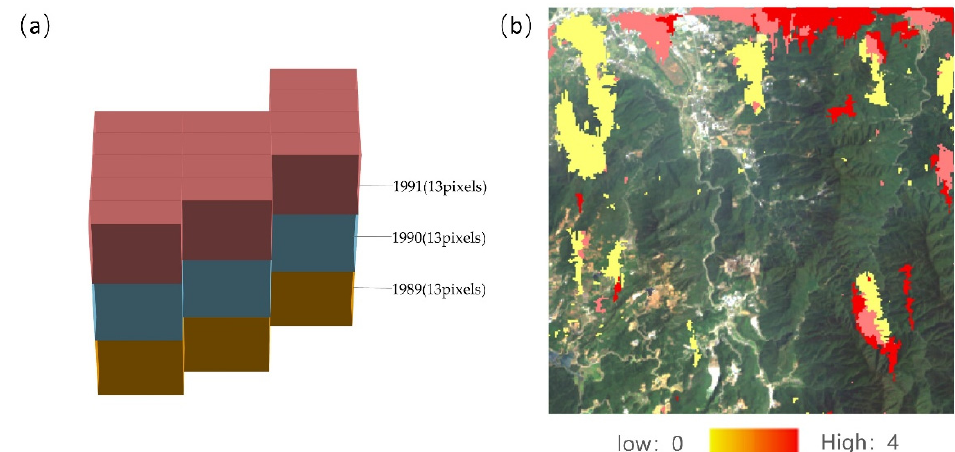
Figure 14. ( a ) Actual SS IST-cube diagram, containing three layers representing three years. The average number of pixels per year is 13, conforming to the criterion for the SS IST-cube class. ( b ) Spatial distribution map of occurrence number of the SS IST-cube.